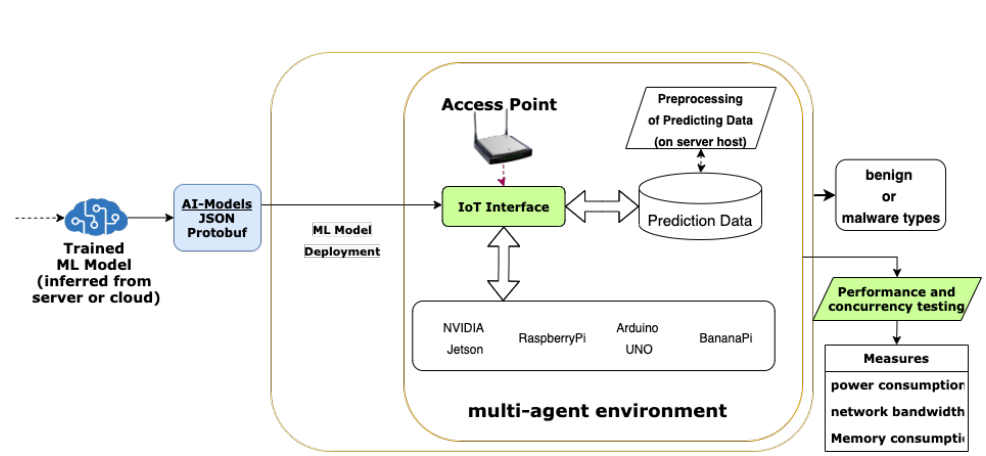
Figure 4. AI model transfer approach performing high inference on server and prediction on IoT